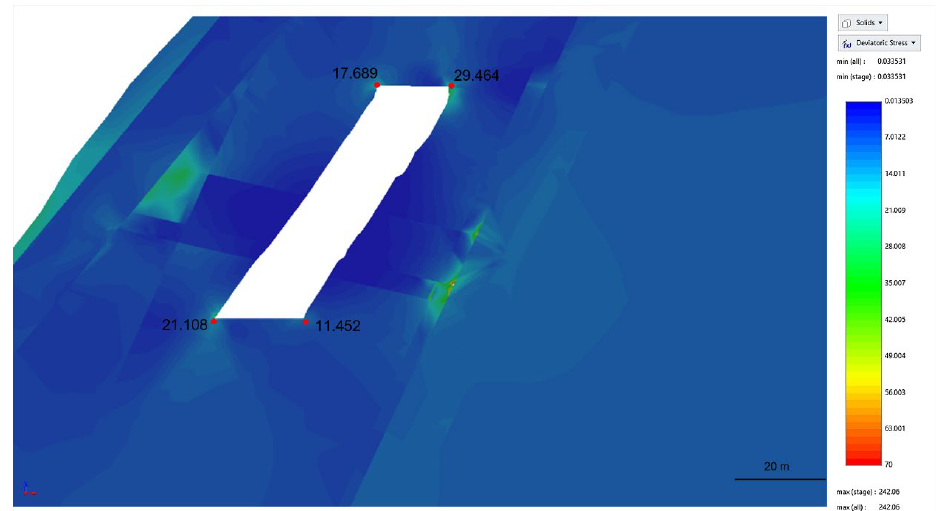
Figure 20. Deviatoric stress ( σ 1 – σ 3 ) of Section S1 calculated in MPa; the model includes the repre- sentation of future excavation.